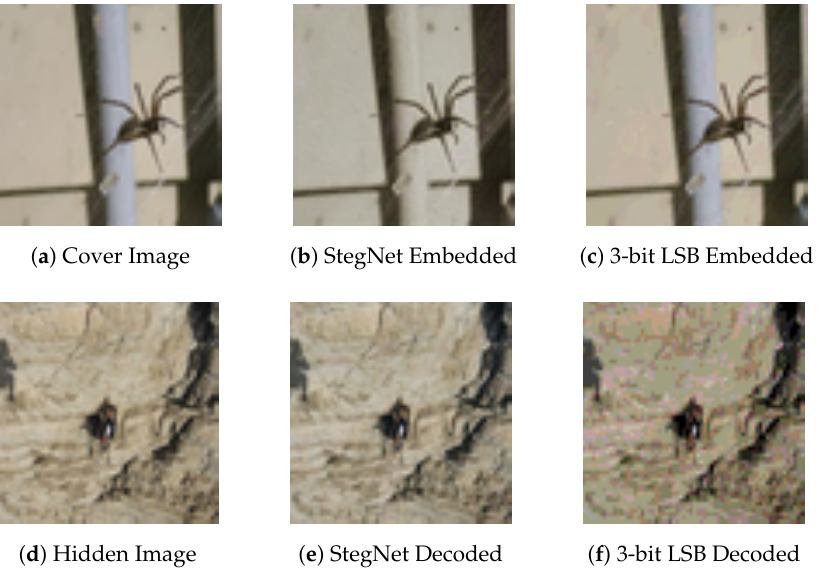
Figure 2. StegNet and 3-bit LSB Comparison Embedded-Cover-Diversity = 0.76%, Hidden-Decoded- Diversity = 1.8%, Payload Capacity = 23.57